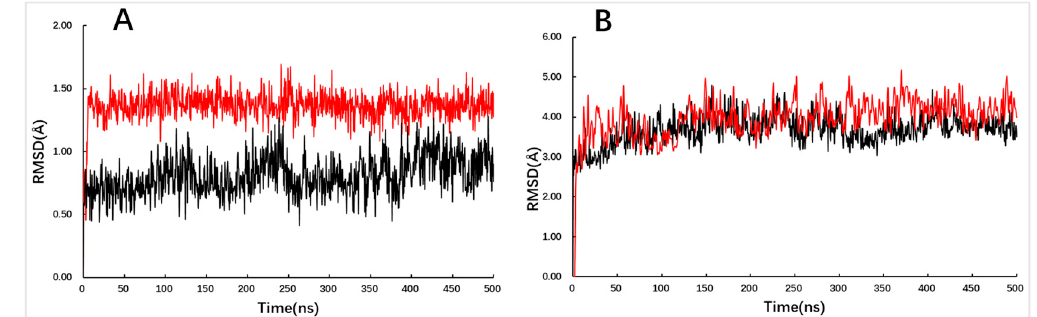
Figure 5. Analysis of MD trajectories for ligand TF2 in complex with HIV-1WT RT (black) and K103N (red) RT. ( A ) RMSD profiles for the ligand TF2 , ( B ) RMSD profiles for the protein backbone. Compound TF2 bound to WT and K103N RTs in similar binding modes, the binding modes of TF2 within the NNRTI-binding pocket resembled other diarylpyrimidines as the typical conformation (U shape), as noted in the snapshots collected at the end of the MD trajectories (Figure 6). However, there were some differences in the orientation of some groups and the distance between them and several remarkable features and well- known interactions were delineated here.